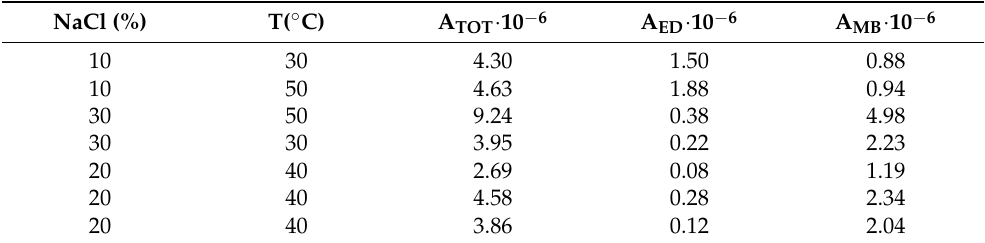
Table 3. Points of the DoE adopted to investigate SPME efficiency of the CW/DVB fiber with experimental values of the responses: total area of the GC chromatogram (A TOT ), peak areas of ethyl decanoate (A ED ), and 3-methyl-1-butanol (A MB ).